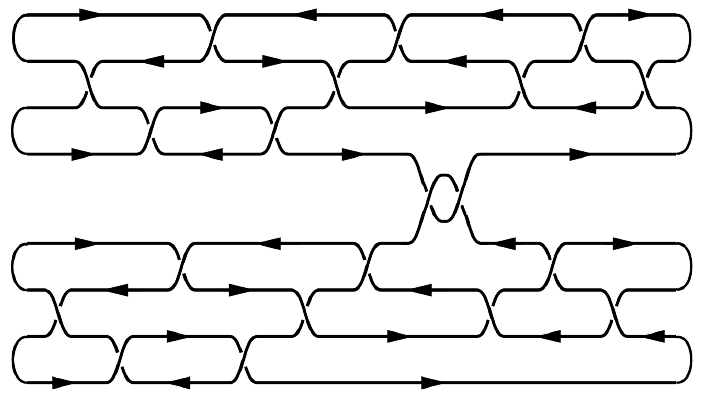
Figure 3. The plat representation corresponding to two-qubits: four-bridge